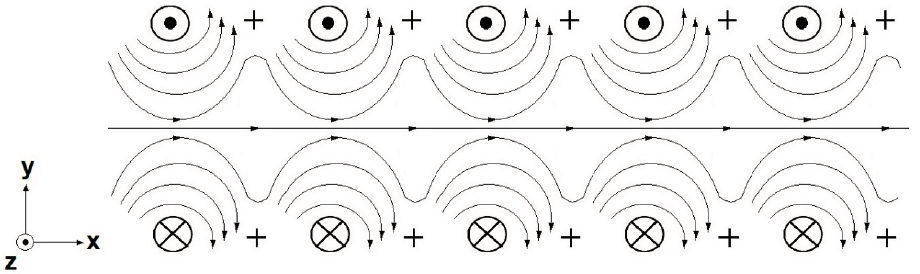
Figure 3. Magnetic flux that is not concatenated by the transformer secondary